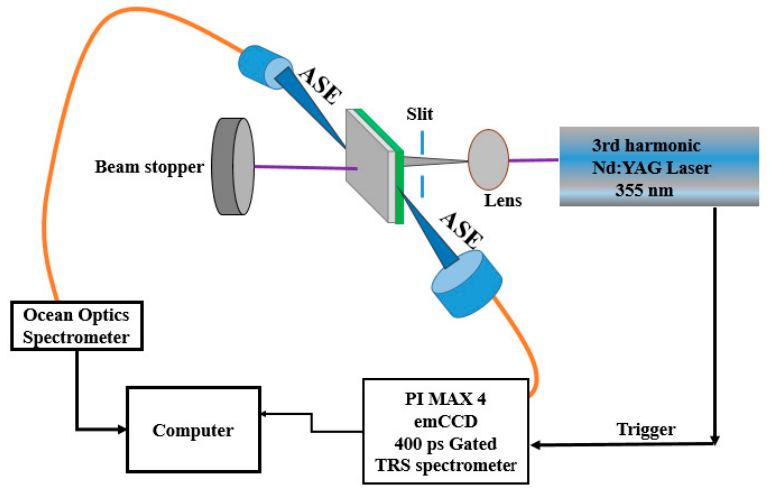
Figure 2. Laser experimental setup for the CO films.